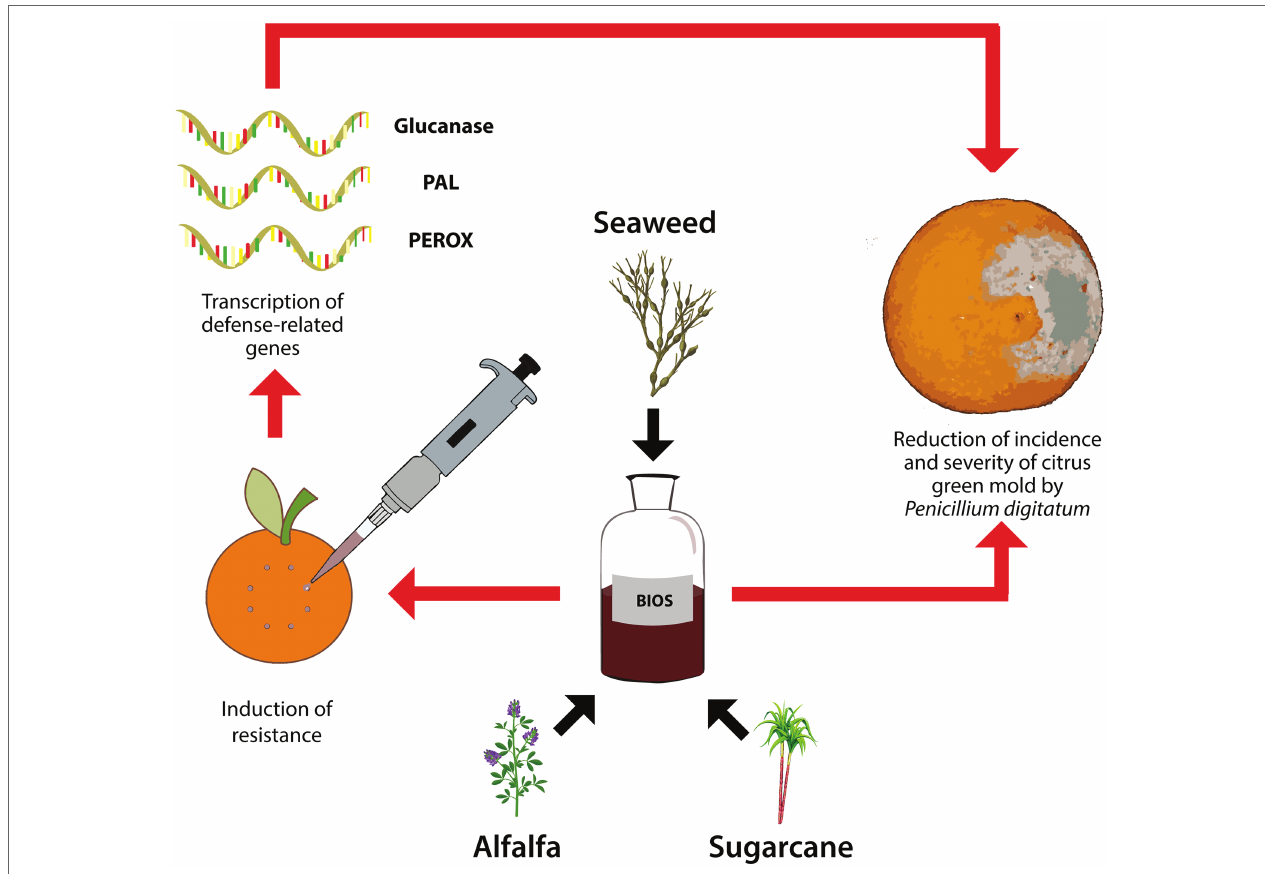
FIGURE 1 | Graphical summary of the proposed experimental design for studying the effectiveness of the experimental natural biostimulant (BIOS) in triggering the transcription of plant defense-related encoding genes ( β -1,3-glucanase – Glucanase, phenylalanine ammonia-lyase – PAL, and peroxidase – PEROX) and in the reduction of incidence and severity of citrus green mold by Penicillium digitatum